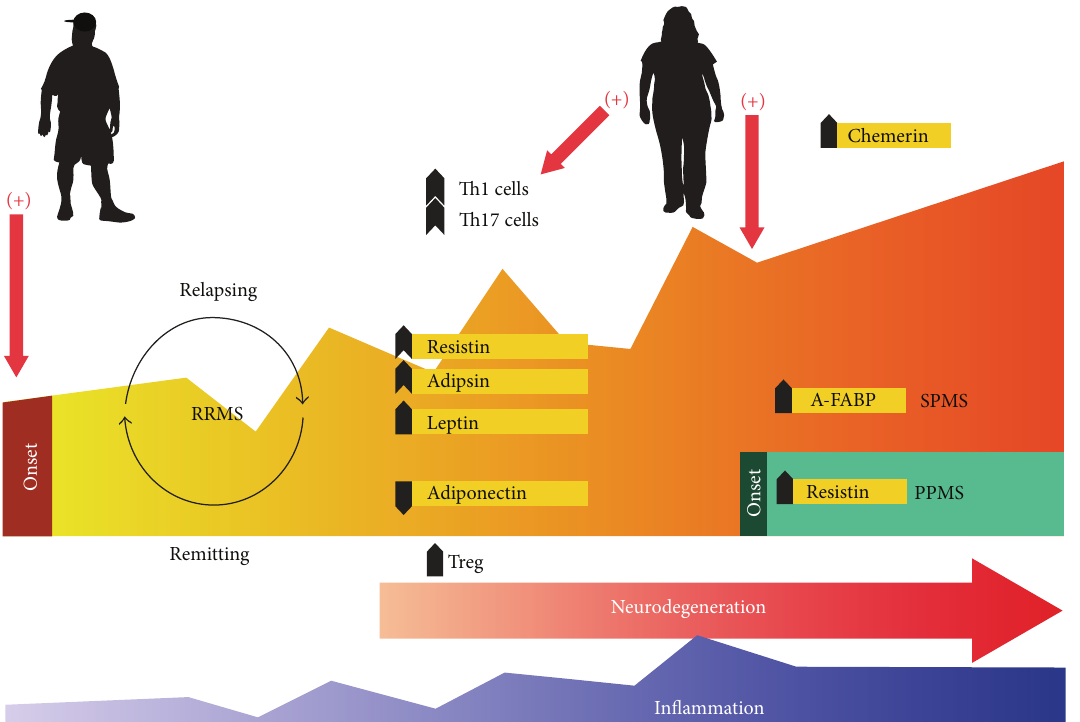
Figure 1: An integrative view of the possible involvement of some adipokines present in patients with multiple sclerosis (MS) at different disease stages. Obesity during adolescence constitutes a relevant risk factor for the later development of MS. Adult obesity negatively affects evolution of the disease and response to treatment in patients with MS. During relapsing-remitting stages, a decrease in adiponectin has been reported as well as, concomitantly, an increase in resistin, adipsin, and leptin concentrations (in serum or CSF or both). Additionally, A-FABP is increased in patients with SPMS, and resistin is also increased in patients with PPMS. Given that inflammation occurs at a variable intensity fromtheonsetofthediseaseandthatneurodegenerationprocessstartsafterdiseaseinitiation,inthiscontexttheadipokinesproducedbylipid tissue constitute an additional element in the neuroimmunomodulation complex of organisms with MS (see text for further explanation); thus the adipokines produced constitute an additional element in the neuroimmunomodulation complex of organisms with MS (see text for further explanation). RRMS, Remittent Recurrent Multiple Sclerosis. SPMS, Secondary Progressive Multiple Sclerosis. PPMS, Primary Progressive Multiple Sclerosis. CSF, CerebroSpinal Fluid. Resistin (serum) [32–34]. Adipsin (in CSF) [35]. Leptin (serum and CSF) [35]. Adiponectin (in serum) [32, 36, 37]. Chemerin (serum) [38]. A-FABP, Adipocyte-Fatty Acid-Binding Protein (in serum)